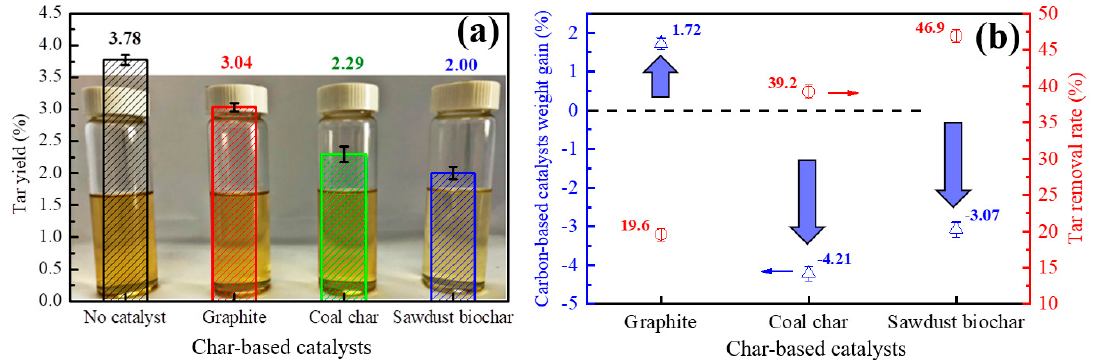
Figure 1 . In-situ biomass tar reforming results over char-based catalysts: ( a ) Tar yields, and ( b ) weight gain and tar reforming rate for the char-based catalysts.